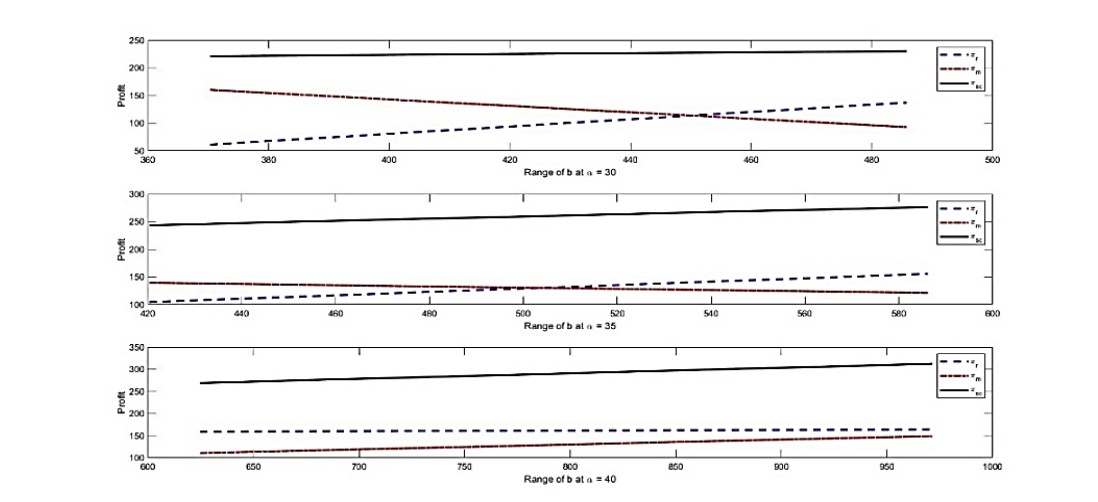
Fig. 10. The trend of variations in firms' profits due to variations in parameter 𝛂 post-contract. Analyses revealed that with increasing the coefficient of parameter α , the profit of all members in the contract increased, and also with increasing this coefficient, the profit of the whole network increased in the contract . Table 13 shows the trend of variations in firms' profits due to variations in parameter β post- contract for sample problem 1 . Table 13. The trend of variations in firms' profits due to variations in parameter β post-contract.